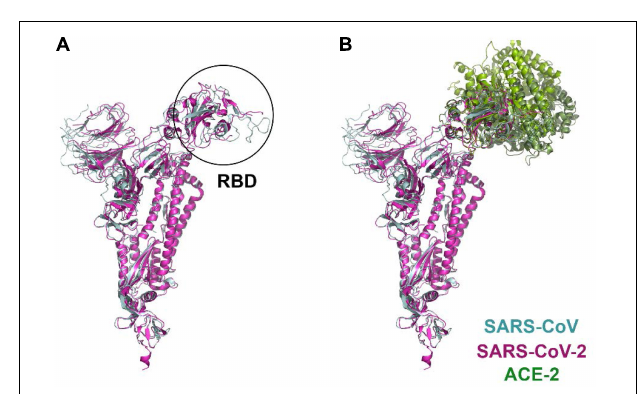
FIGURE 2 | Structural comparison of SARS-CoV and SARS-CoV-2 spike proteins in complex with the ACE-2 receptor. (A) protomer superposition of SARS-CoV ( blue ) and SARS-CoV-2 ( pink ). (B) structures of the complex formed by the RBD of SARS-CoV ( blue ) and ACE-2 ( light green ) (PDB id: 2ajf; Li et al., 2005), and the RBD of SARS-CoV-2 ( pink ) and ACE-2 ( dark green ) (PDB id: 6vw1, Shang et al., 2020a; PDB id: 6m17, Yan et al., 2020; PDB id: 6lzg, Wang Q. et al., 2020), respectively, have been aligned and superimposed using UCSF Chimera (Pettersen et al., 2004). this region (Arg 426 → Asn 439 , Tyr 442 → Leu 455 , Leu 443 → Phe 456 , Phe 460 → Tyr 473 , Leu 472 → Phe 486 , and Tyr 484 → Gln 498 ; SARS-